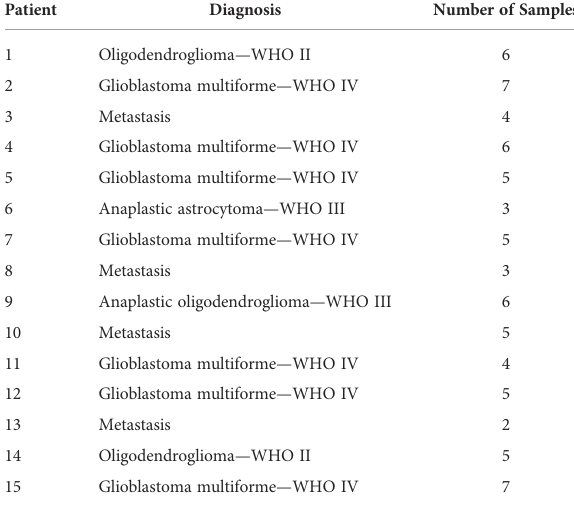
TABLE 1 Overview over the different patients and their diagnosis and the number of samples considered during the tissue analysis.